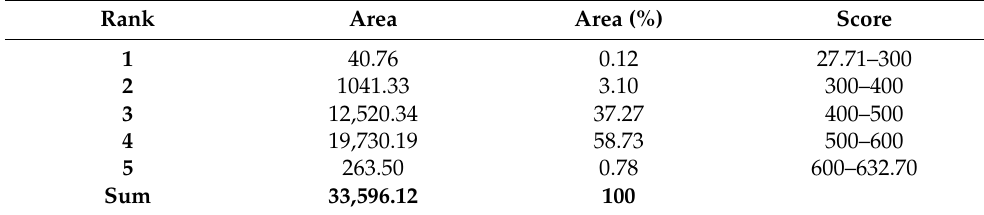
Table 5. Areas of suitability map classes based on AHP detailed in 5 classes.